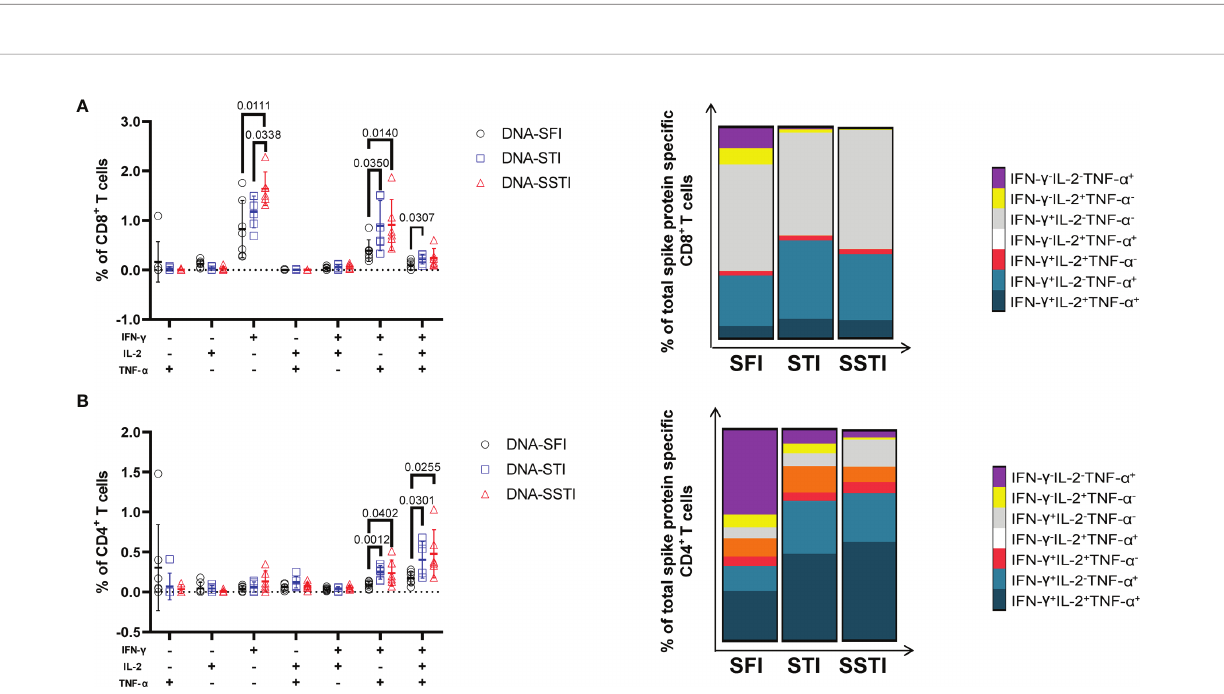
FIGURE 5 | Speci fi c T cell responses elicited by the S DNA vaccine at 5 weeks post the 3 rd immunization. Splenocytes were collected from each mouse at 5 weeks post the 3 rd immunization. Frequencies of S protein speci fi c IFN- g , IL-2 and TNF- a secreting CD8 + T cells (A) and CD4 + T cells (B) were detected by ICS. iMFI (Speci fi c T cell frequency multiplied by MFI) of speci fi c CD8 + (C) and CD4 + T cells (D) was compared among different inoculation strategies. Data are shown as mean ± SD. Statistical differences among groups was analyzed using